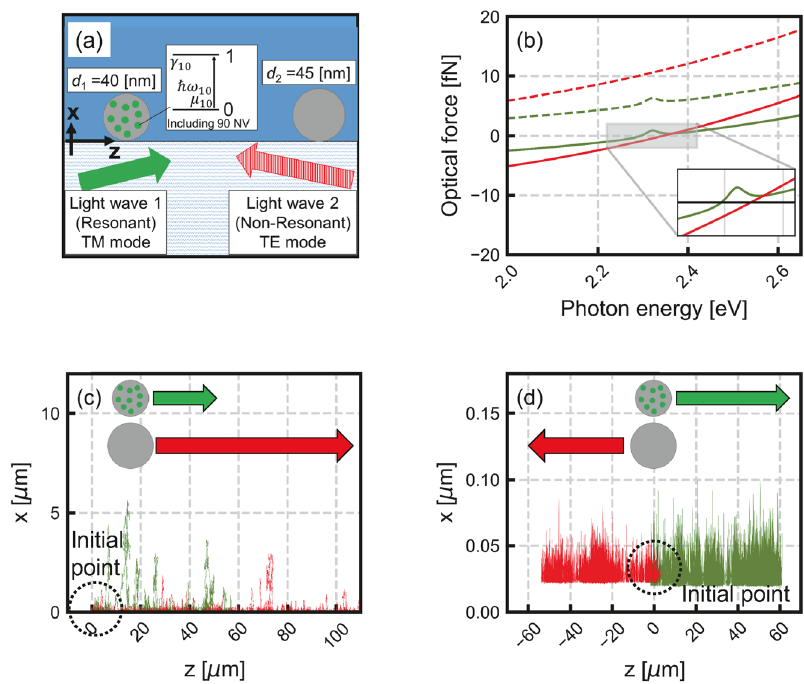
Figure2: (a)Modelofopticalmanipulationof nano-diamond particles with NV-centers by the counter-propagating evanescent waves at the interface between glass and